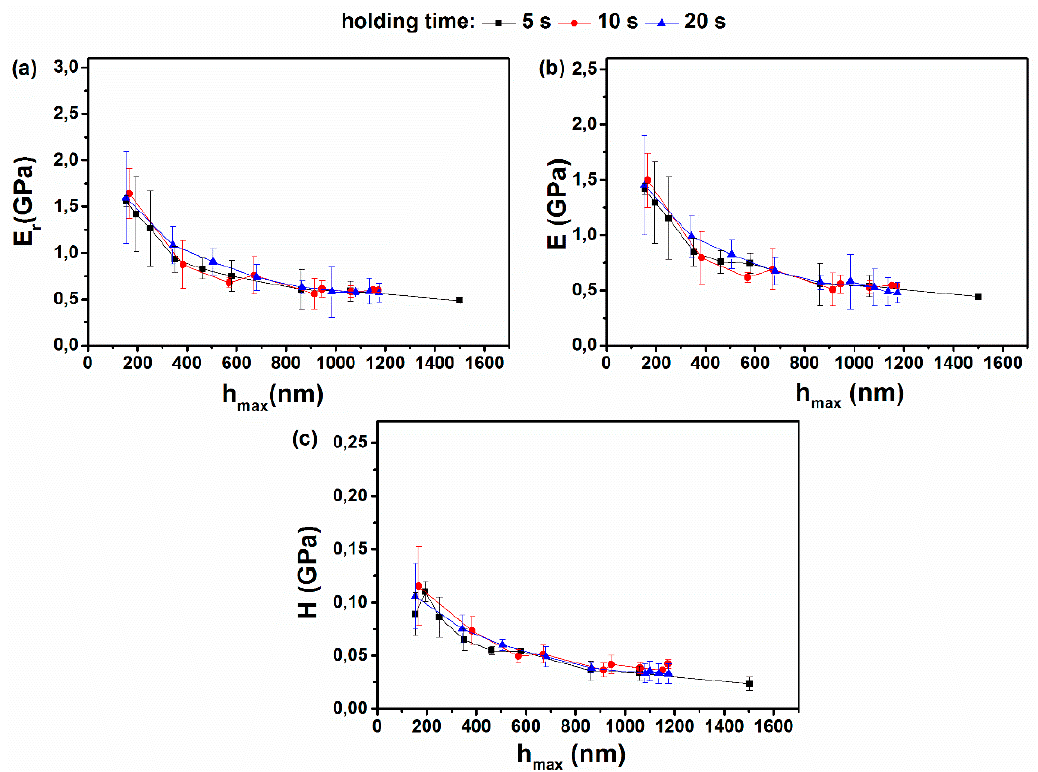
Figure 9. ( a ) Reduced modulus (Er); ( b ) Young’s modulus (E); and ( c ) hardness (H) values as a function of maximum indentation depth for 5, 10, and 20 s holding time for the CS- g -PCL copolymer. Table 2. Young’s modulus and hardness values of the tested samples at a 1000 nm indentation depth. Sample